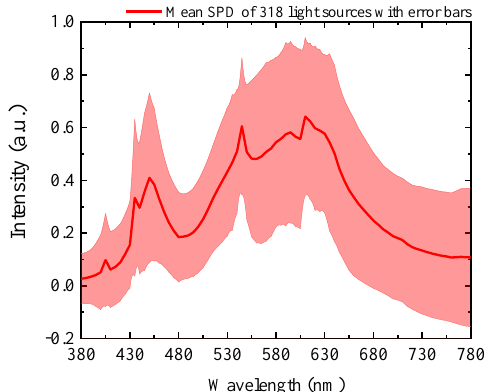
Figure 3. Mean spectral power distribution (SPD) of 318 light sources with error bars, as provided by the Illuminating Engineering Society of North America (IES-30-15). The corresponding colorimetric parameters were as follows: correlated colour temperatures (CCT) 3628 K, x = 0.397, y = 0.384, CIE Ra = 87, IES R f = 86, and R g = 100.